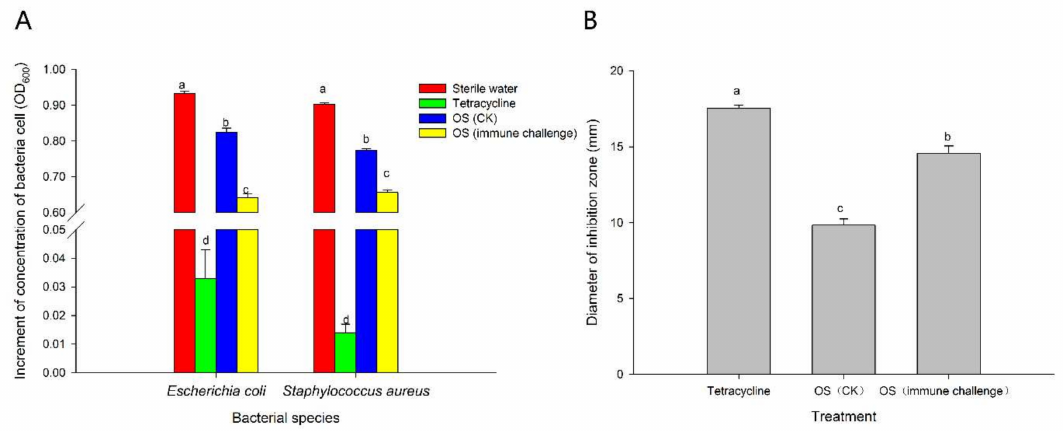
Figure 3. Microbial growth inhibition assays of oral secretions on ( A ) bacteria and ( B ) fungi in red palm weevil (RPW) larvae after immune challenge with Metarhizium anisopliae . Data are shown as the mean ± SE from ten independent biological repetitions. Di ff erent lowercase letters above the bar indicate statistically significant di ff erences among di ff erent treatments for the same indicator microbe at p < 0.05 (one-way ANOVA followed by Tukey’s HSD multiple